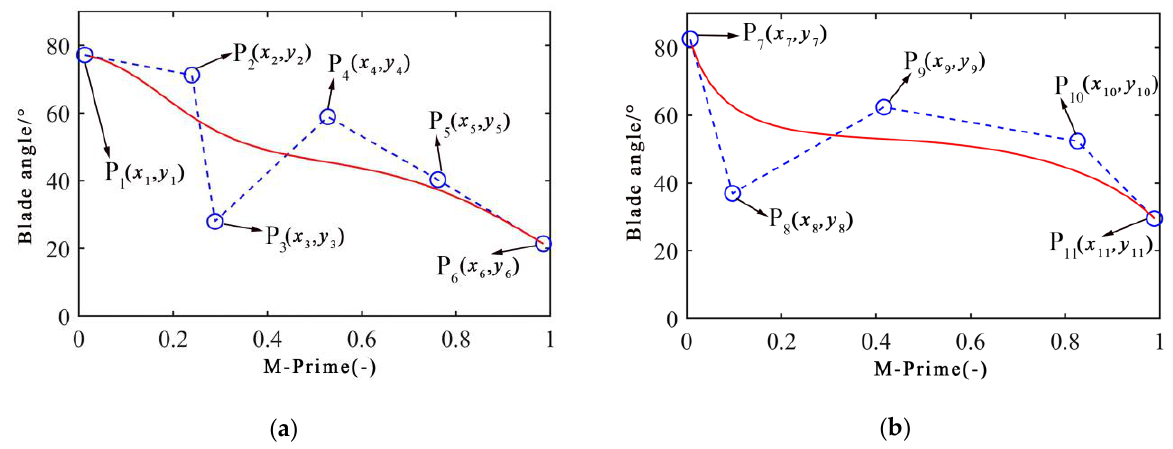
Figure 9. Placement angle distribution of impeller-guide vane. ( a ) Impeller placement angle control; ( b ) Guide vane placement angle control.